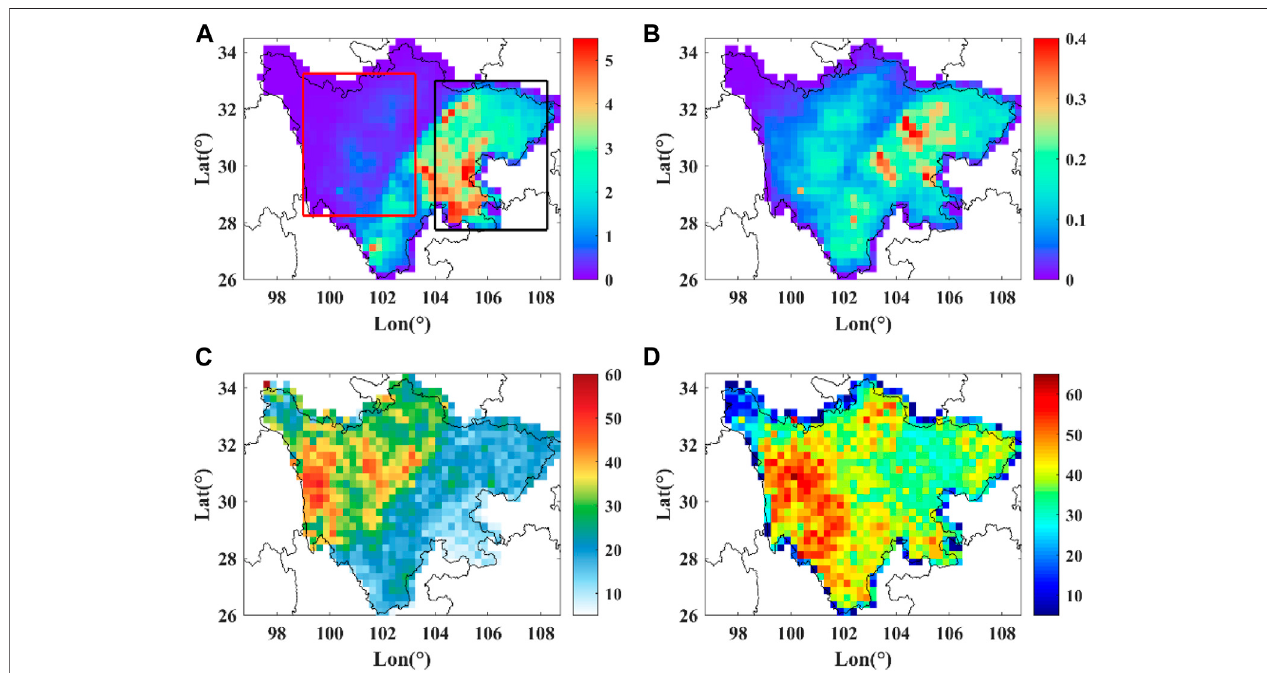
FIGURE 1 | Spatial distribution of (A) total CG lightning density (in fl ashes km − 2 year − 1 ), (B) positive CG lightning density (in fl ashes km − 2 year − 1 ), (C) positive CG lightningpeak current (in kA),and (D) positiveCGlightning relative frequency(in %)inSichuanduring thewarm season. Thered rectangle representstheplateau region, and the black rectangle represents the basin region.